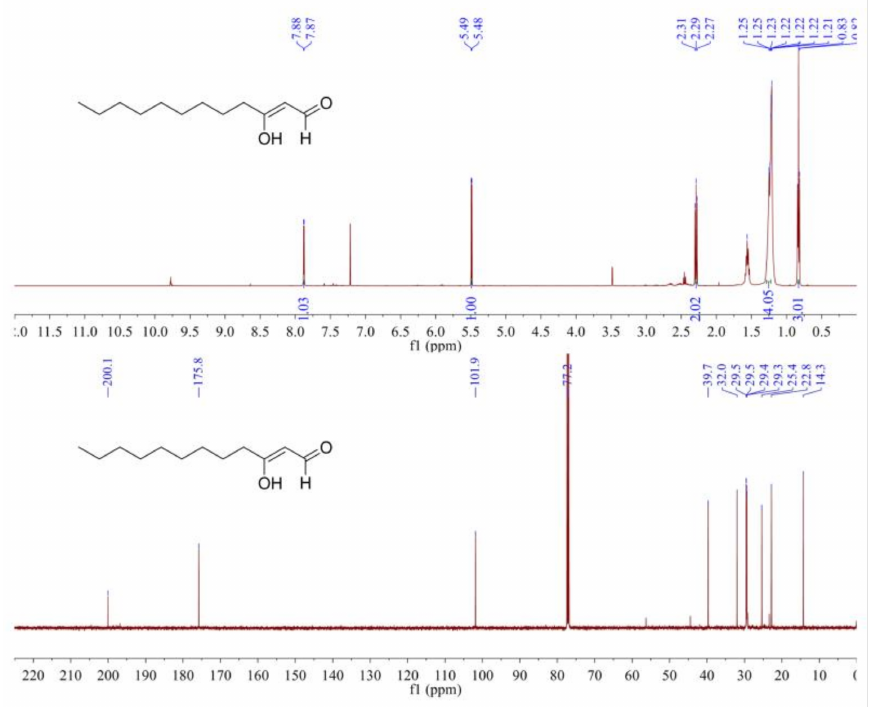
Figure 3. The 1 H NMR spectrum and 13 C NMR spectrum of Hou in CDCl 3 .